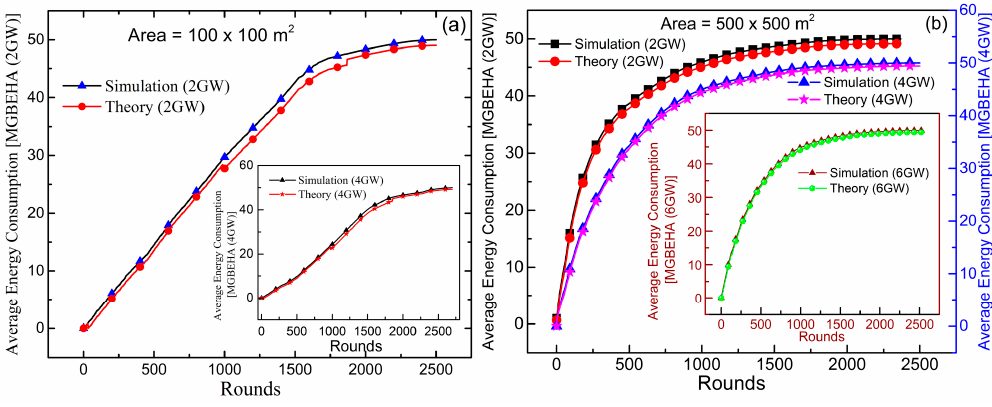
Figure 13. Average energy consumption in ( a ) 100 m 2 area with 2 GW and 4 GW and ( b ) in 500 m 2 with 2 GW, 4 GW, and 6 GW.